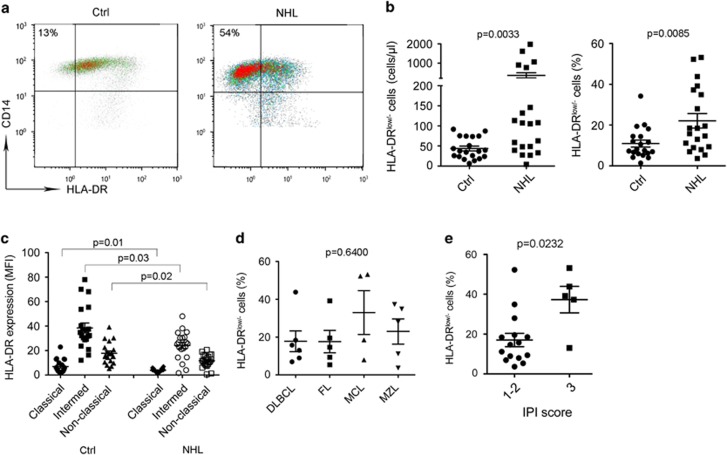
Monocytes from B-cell NHL exhibit CD14+HLA-DRlow/− phenotype. (a) Representative plots showing coexpression of CD14 and HLA-DR in blood from healthy donors (Ctrl) and lymphoma patients (NHL). CD14+HLA-DRlow/− cells were defined based on isotype control gate. (b) Graphs showing absolute counts (left) or the percentage (right) of CD14+HLA-DRlow/− cells in blood from NHL patients and healthy donors measured by flow cytometry. (c) Graphs showing expression level of HLA-DR on classical, intermediate and non-classical monocytes in blood from NHL patients and healthy donors. (d) A graph showing the percentage of CD14+HLA-DRlow/− monocytes in blood from NHL patients with different histologies. (e) Graphs showing the percentage of CD14+HLA-DRlow/− monocytes in blood from NHL patients with different International Prognostic Index (IPI) scores.